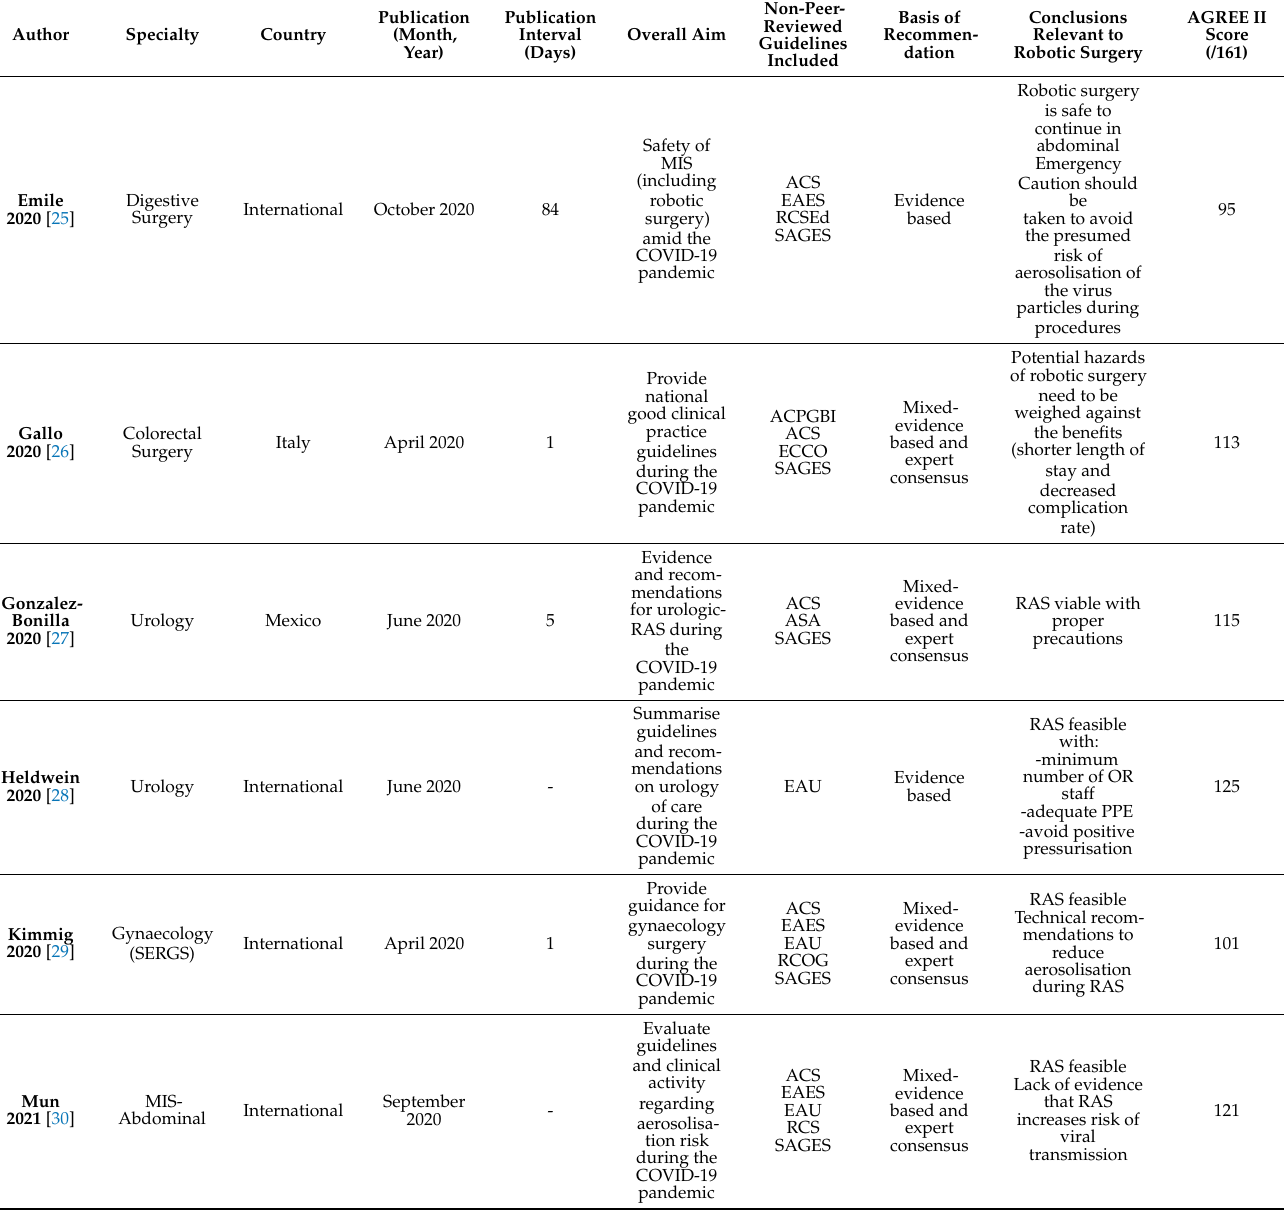
Table 2. Study and publication characteristics of peer-reviewed, published recommendations and guidelines related to robotic surgery during the SARS-CoV-2